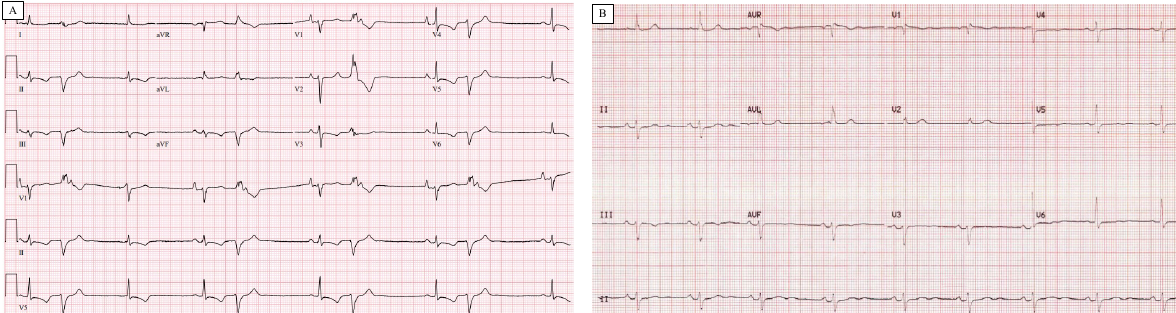
Figure 3. 12-lead ECG in a patient with bileaflet MVP. ( A ) ECG reveals TWI in multiple leads as well as bigeminal PVCs that have a posteromedial papillary muscle morphology. ( B ) Repeat ECG following PVC ablation demonstrates an improvement in TWI.